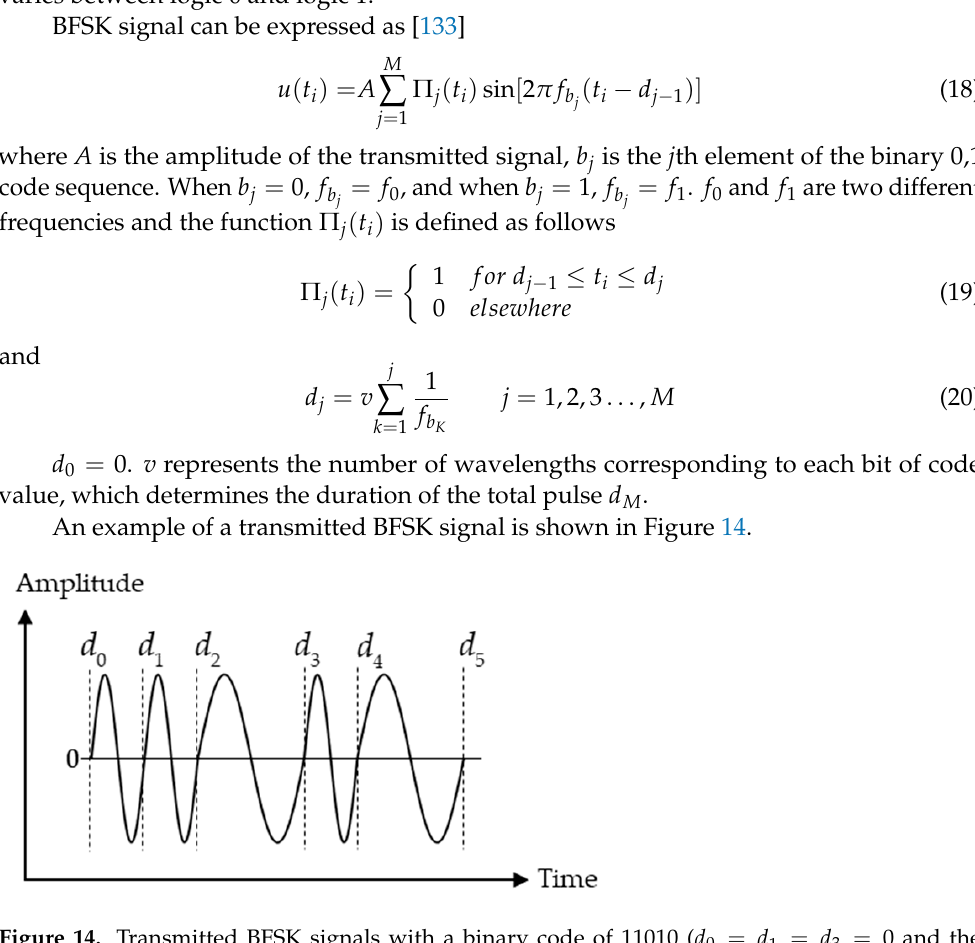
= and the corresponding frequency is f , 1 d d = 0